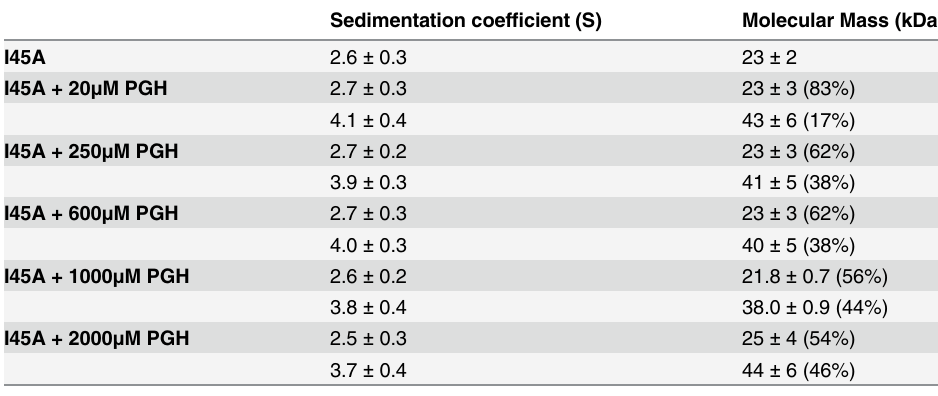
Table 4. AUC data analysis for I45A mutant in 20 mM